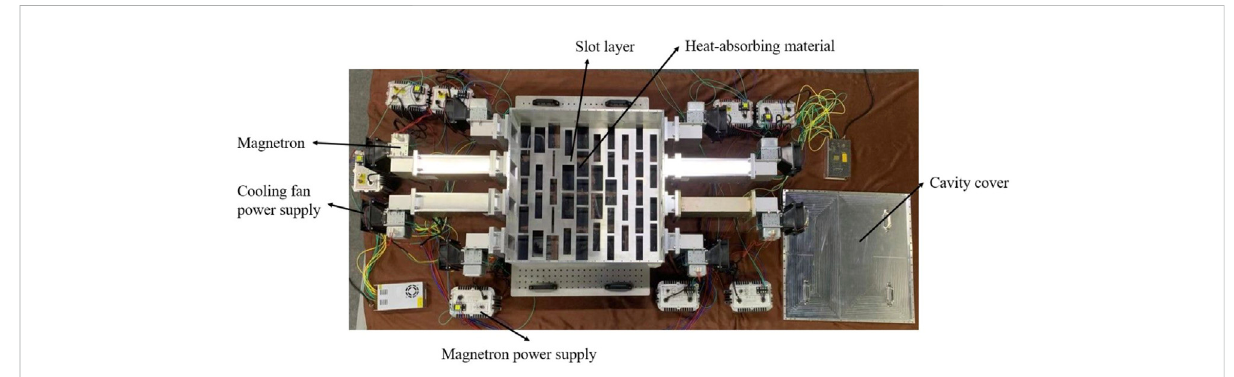
FIGURE 10 Experimental setup system.